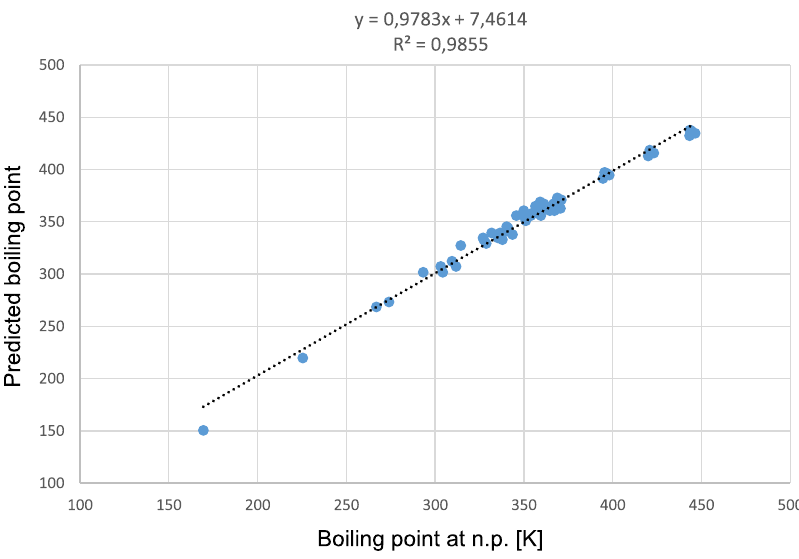
Figure 3. Boiling points and predicted boiling points for all considered alkenes. Table 4. Data for the alkenes in the test